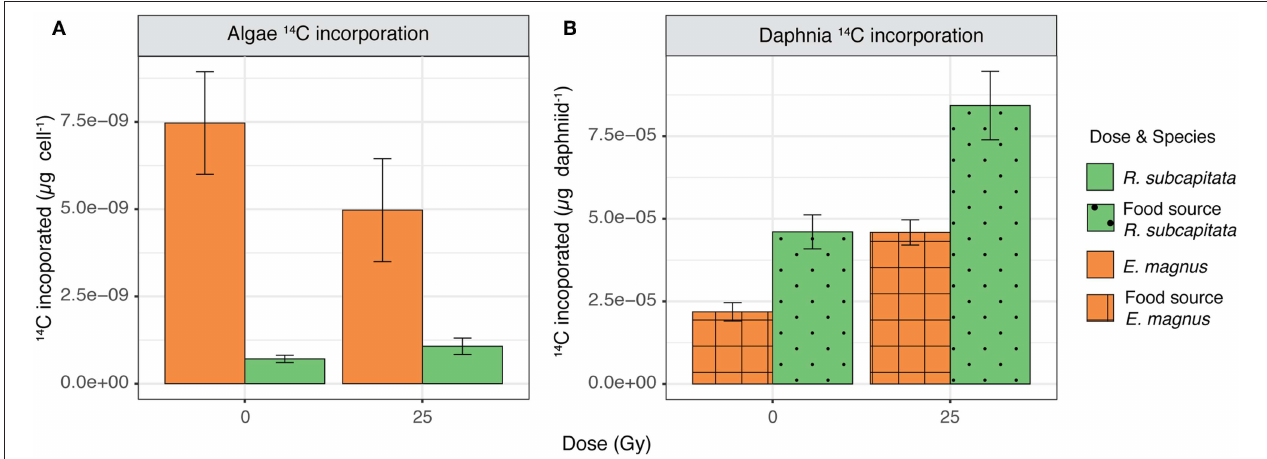
FIGURE 6 | 14 C incorporation in (A) R. subcapitata and E. magnus (mean ± SE; n = 6) and (B) D. magna when reared on R. subcapitata and E. magnus under control conditions and exposed to 25Gy of È -radiation (mean ± SE; n =